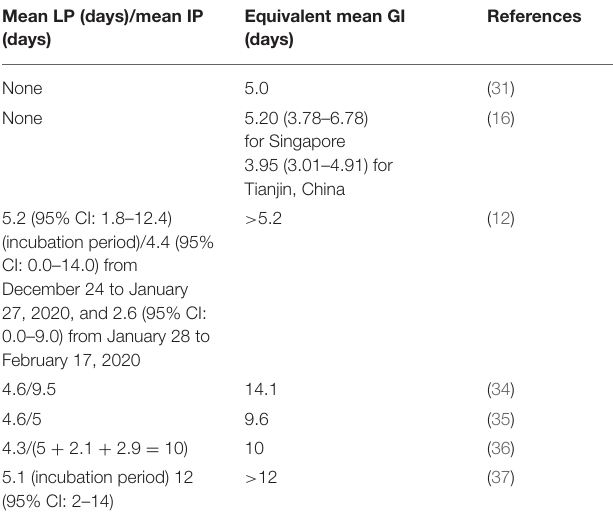
TABLE 1 | Mean latent period and mean infectious period of COVID-19. TABLE 2 | Summary results of the estimated infection attack rates (AR) in Belgium, Israel, and the UAE by February 18,